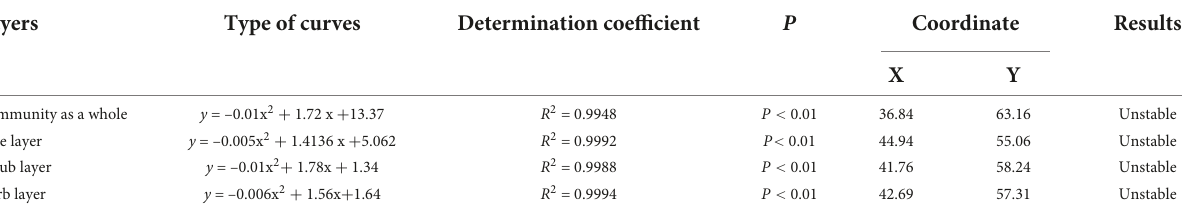
TABLE 6 Results of community stability (M. Godron’s